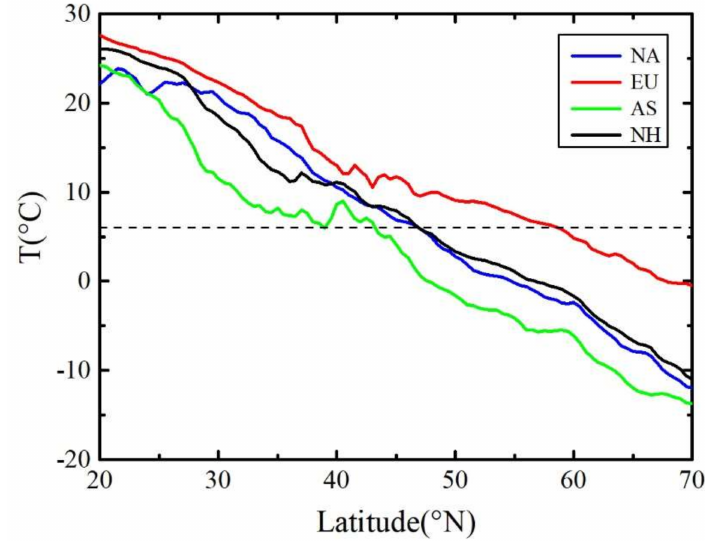
Figure 12. Annual mean air temperatures at different latitudes in the Northern Hemisphere (north of 10 ◦ N) during the period 2003–2016, where NA represents North America, EU represents Europe, AS represents Asia and NH represents the Northern Hemisphere. The dotted line represents 6.5 ◦